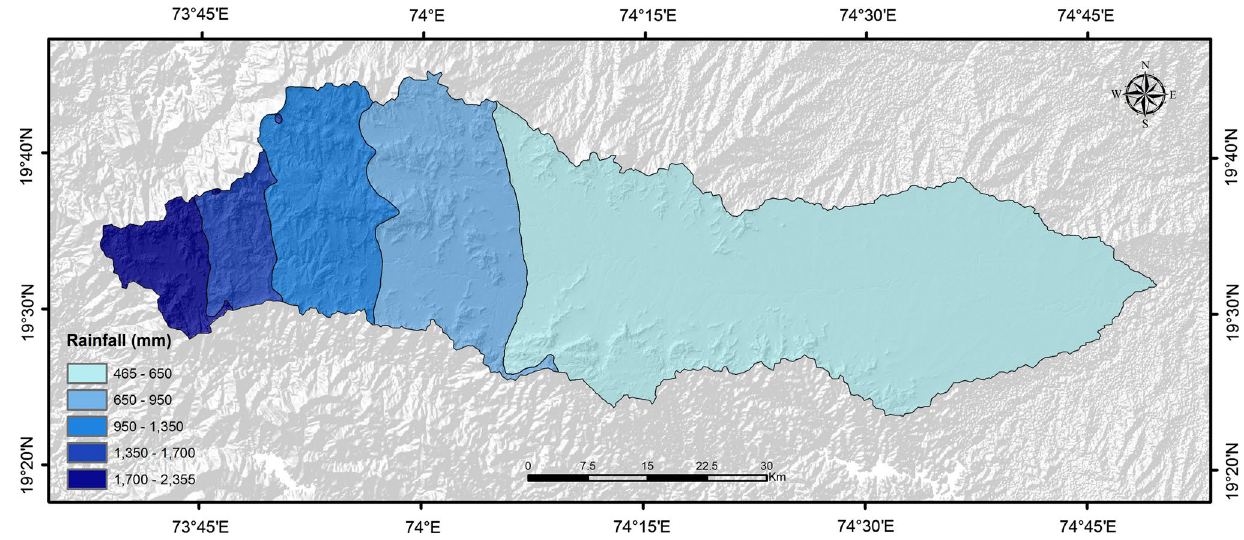
Fig. 10 Rainfall distribution map of the study